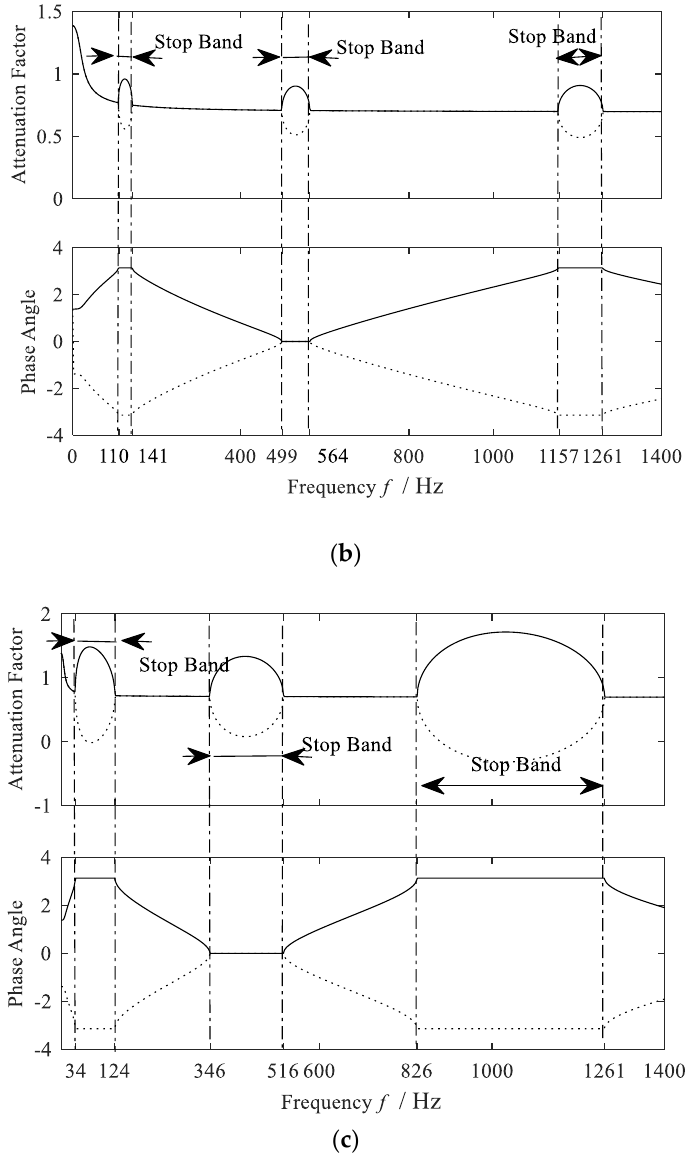
Figure 6. Numerical propagation constants derived from three different modes, ( a ) is derived with Mode I, ( b ) is derived with Mode II and ( c ) is derived with Mode III.